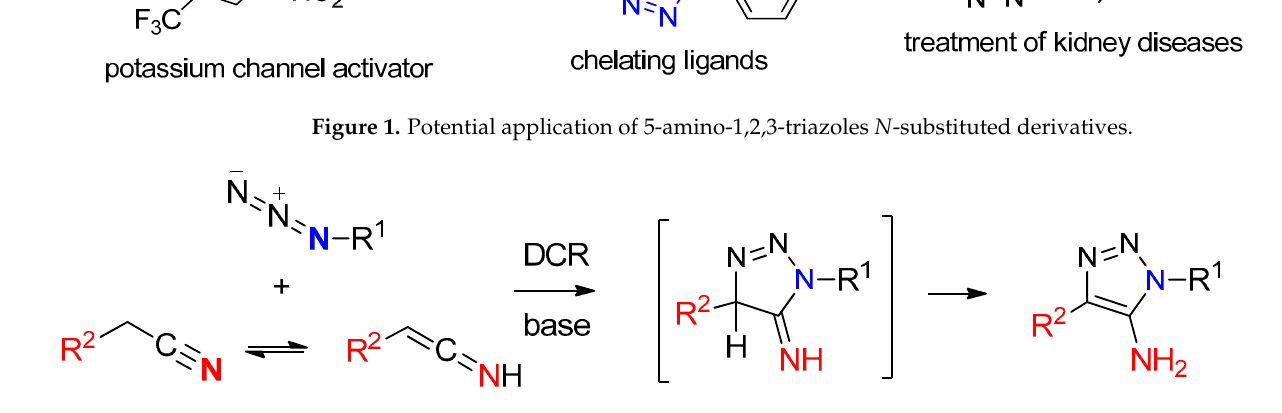
Scheme 1. 1,3-Dipolar cycloaddition reaction (DCR) between aryl azides and monosubstituted ace- tonitriles.